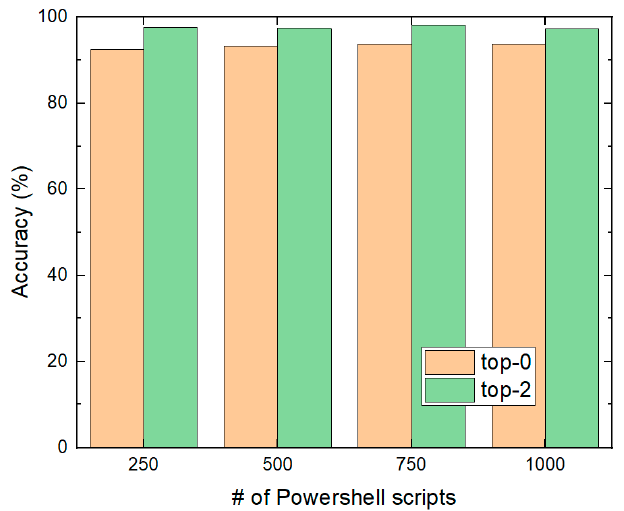
Figure 10. Accuracy by number of powershell scripts.